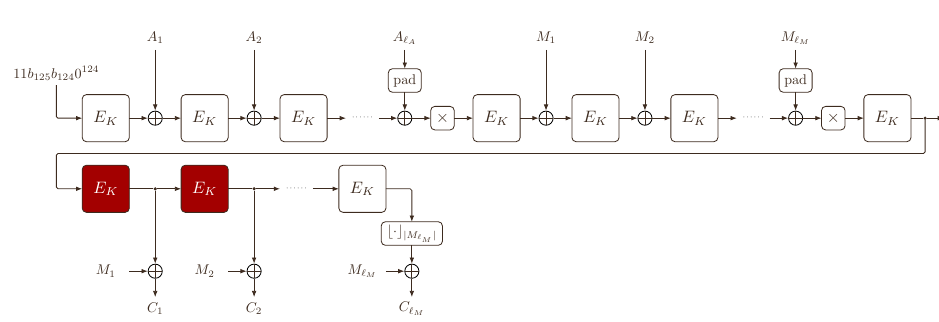
Figure 1: Encryption of GIFT-COFB .